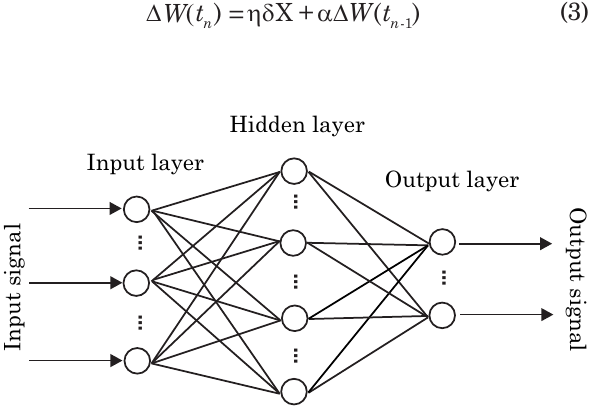
Figure 1. Structured chart of neural